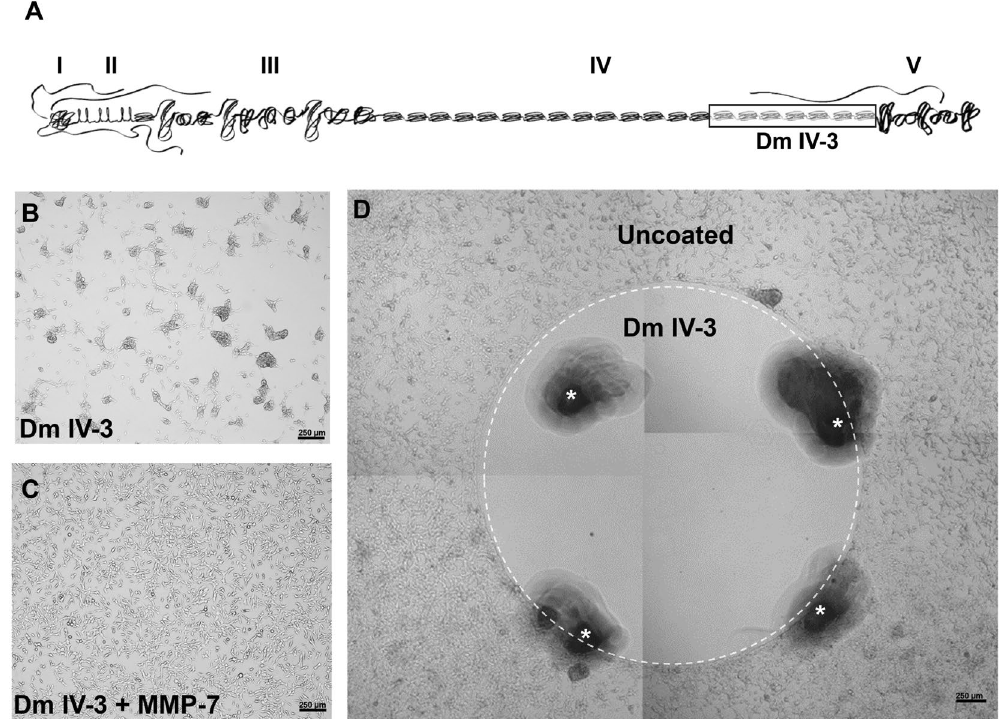
Figure 3. Perlecan Domain IV-3 mediates a strong repulsive/clustering effect on C4-2 cells as does full length perlecan. ( A ) Schematic of full length perlecan highlighting Domain IV-3 (the last 7 Ig repeats of Domain IV). A reverse phase protein array (RPPA) was performed on cells cultured on wells entirely coated with Domain IV-3 (panel B) or MMP-7 cleaved Domain IV-3 (panel C) for 48 hours. Cells cluster on Domain IV-3 and this is reversed by pre-cleavage with MMP-7. D.) C4-2 cells 72 hours after being cultured on a spot (inside the white dashed circle) of surface adsorbed Domain IV-3. Cells cleared out of the area, creating a border around Domain IV-3. Scalebars are 250 µ m. White asterisks indicate fiduciary markers (black areas) used to approximate the location of the spotted Domain IV-3 at the